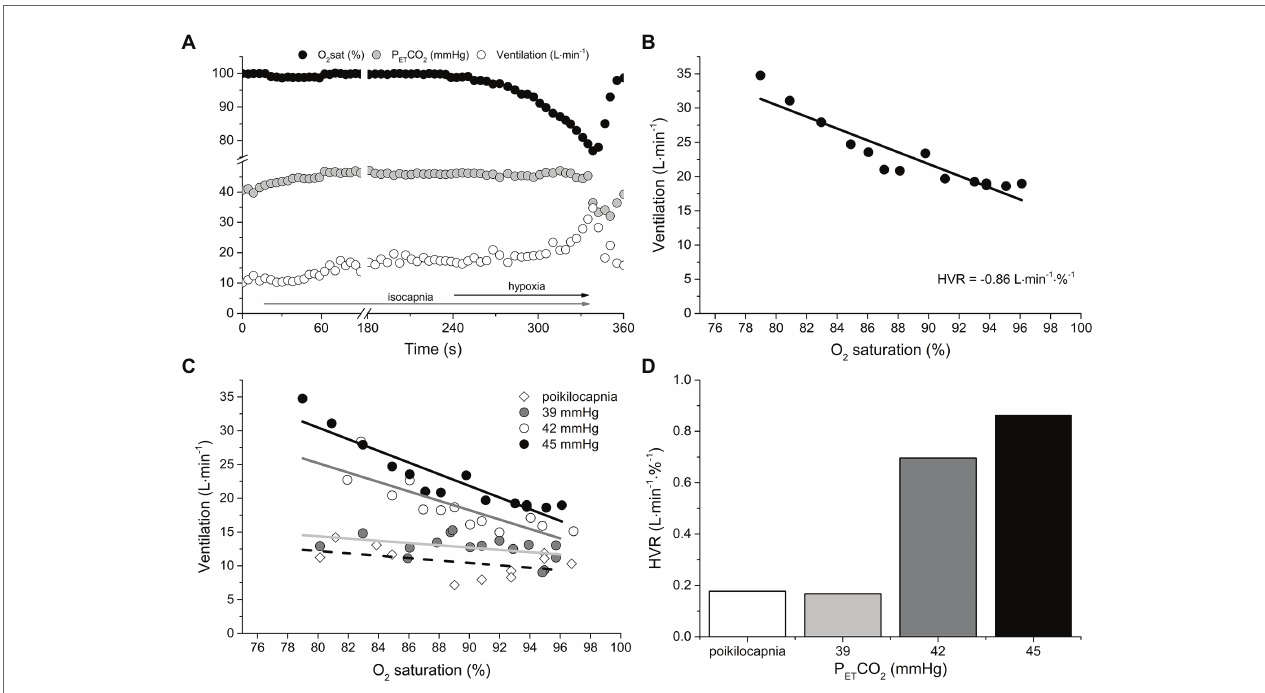
FIGURE 1 | An example of the measurement of peripheral chemoreflex sensitivity using the continuous transient hypoxic method in an isocapnic condition (A) . The rise in ventilation ( V̇ E ) is plotted against the fall in oxygen saturation to build a regression function (B) . The slope of this function, or hypoxic ventilatory response (HVR), is considered a measure of peripheral chemoreflex sensitivity (liters per minute per % oxygen saturation). (C,D) show the effect of isocapnic CO 2 tension (PCO 2 ) on HVR. Note that the HVR varied with isocapnic PCO 2 tension; with greater levels of isocapnia, the sensitivity of the peripheral chemoreceptors to hypoxia is increased, resulting in a greater HVR. In contrast, during the poikilocapnic test, PCO 2 fell as V̇ E rose, and the ventilatory response to hypoxia was nearly eliminated. See text for